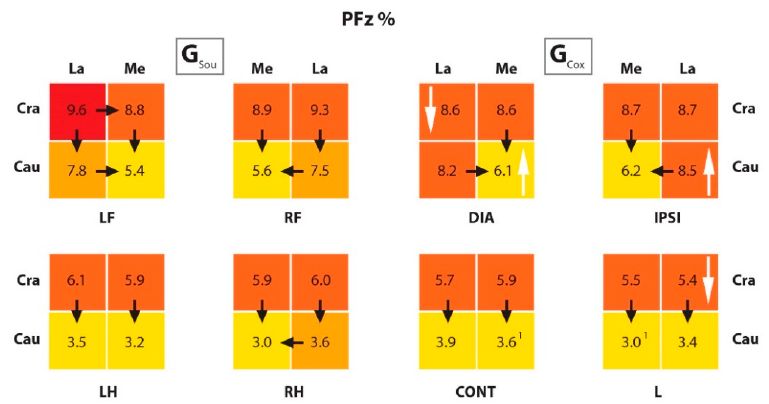
Figure 5. The scheme representing the PFz% in quadrants of the paws from G Sou and G Cox . The black arrows show a significant difference between the quadrants within paws (for example, in the LF limb from G Sou there was a difference between the CraLa and CraMe quadrants) and the white arrows, between groups (for example, there was a difference between the CraLa quadrants from the LF limb in G Sou and DIA limb in G Cox ); and the numbers ( 1 ), between equivalent quadrants in different limbs within a group (for example, in the G Cox , there was a difference between the CauMe quadrants from the CONT and L limbs). The color scale within paws: higher values in darker colors and lower values in lighter colors. PFz% (peak of vertical force normalized as percentual of total force); G Sou (group sound); G Cox (group coxarthrosis); LF (left front limb); RF (right front limb); LH (left hind limb); RH (right hind limb); DIA (diagonal limb); IPSI (ipsilateral limb); CONT (contralateral limb); L (lame limb); Cra (cranio); La (lateral); Cau (caudo); Me (medial).